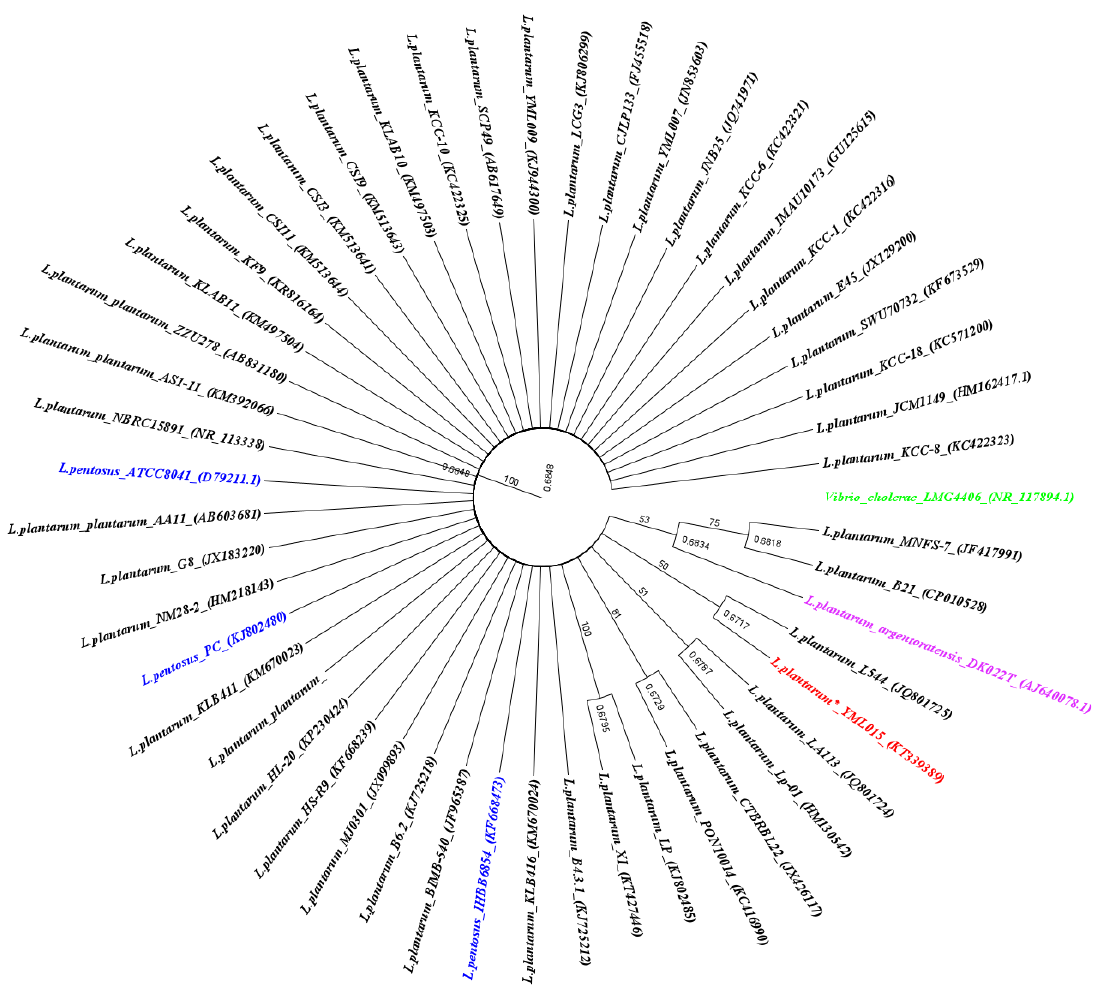
Figure 2. Neighbor-joining phylogenetic tree showing the position of L. plantarum YML015 among the different Lactobacillus strains based on 16s rDNA sequence.